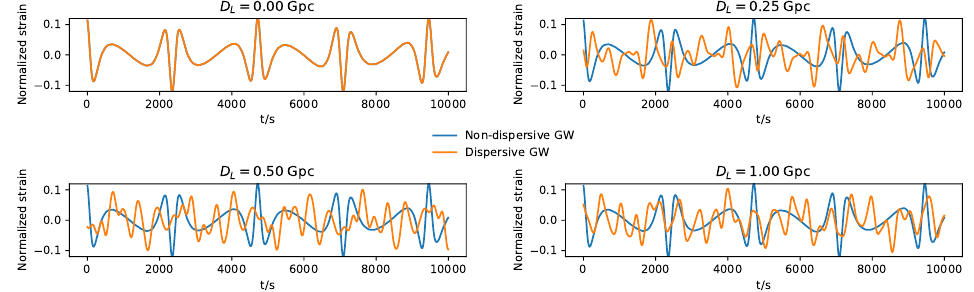
Figure 2. The distortion of gravitational waves from an extreme-mass-ratio inspiral during propagation = 1.6 × 10 13 km) . Total mass: M = 10 6 M (cid:12) ; symmetric mass ratio: ν = 10 − 5 , e = 0.5, (EMRI, λ g p = 12 M , and a = 0.9. We set the luminosity distance of sources D L from 0 to 1.00 Gpc. The orange curves represent the waveforms with dispersion during the propagation, and the cyan one is the nondispersive